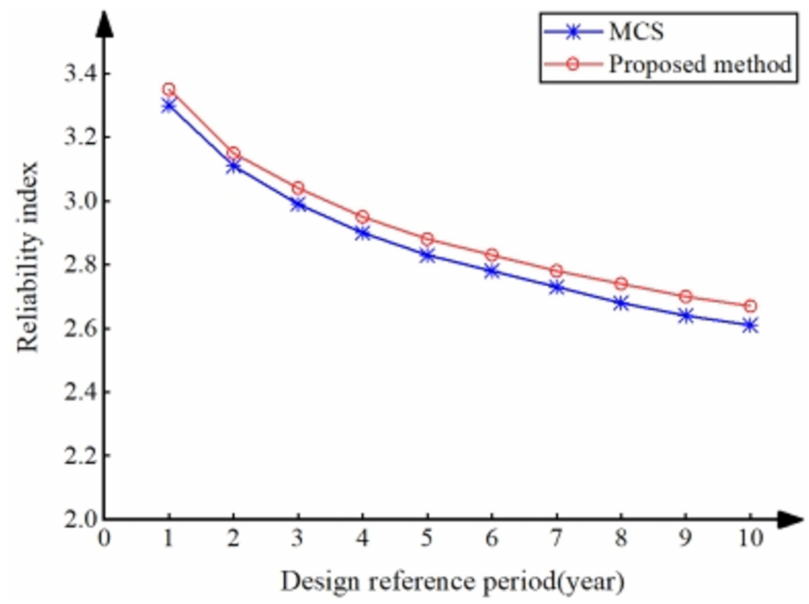
Figure 7. Reliability index curve of roof structure in design reference period. Table 7. Calculation results of Monte Carlo method under different sample numbers.